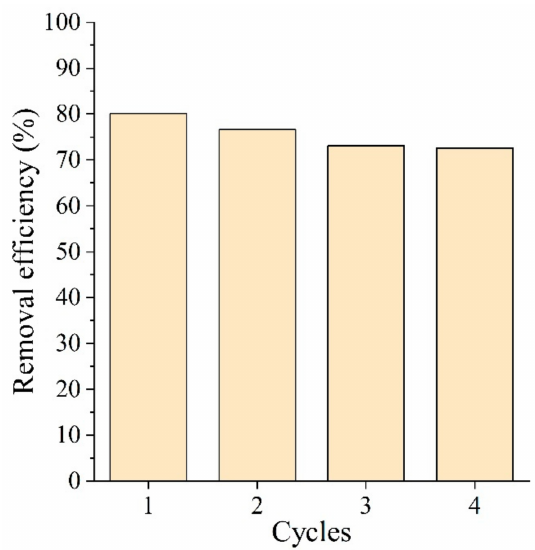
Figure 13. CIP removal efficiency on the MAG-CLI during four adsorption and plasma regeneration cycles ( C 0 = 50 mg dm − 3 , adsorption time = 60 min, T = 298 K and pH =